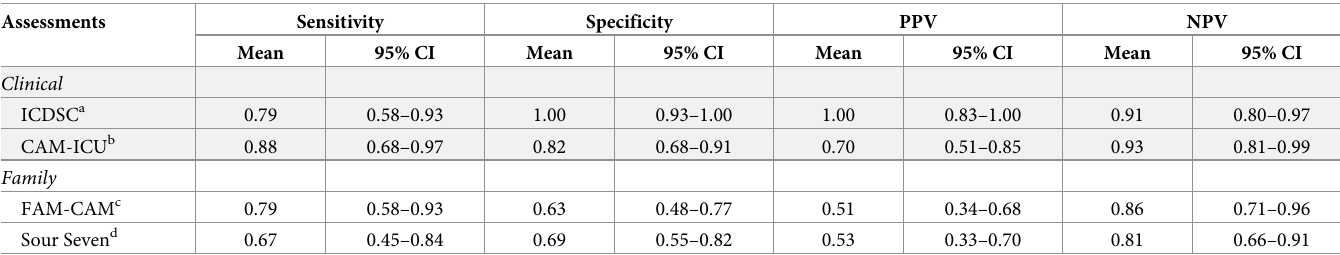
Table 3. Diagnostic criteria for clinical and family delirium assessments from latent class analysis for pooled, whole sample ( n = 73).